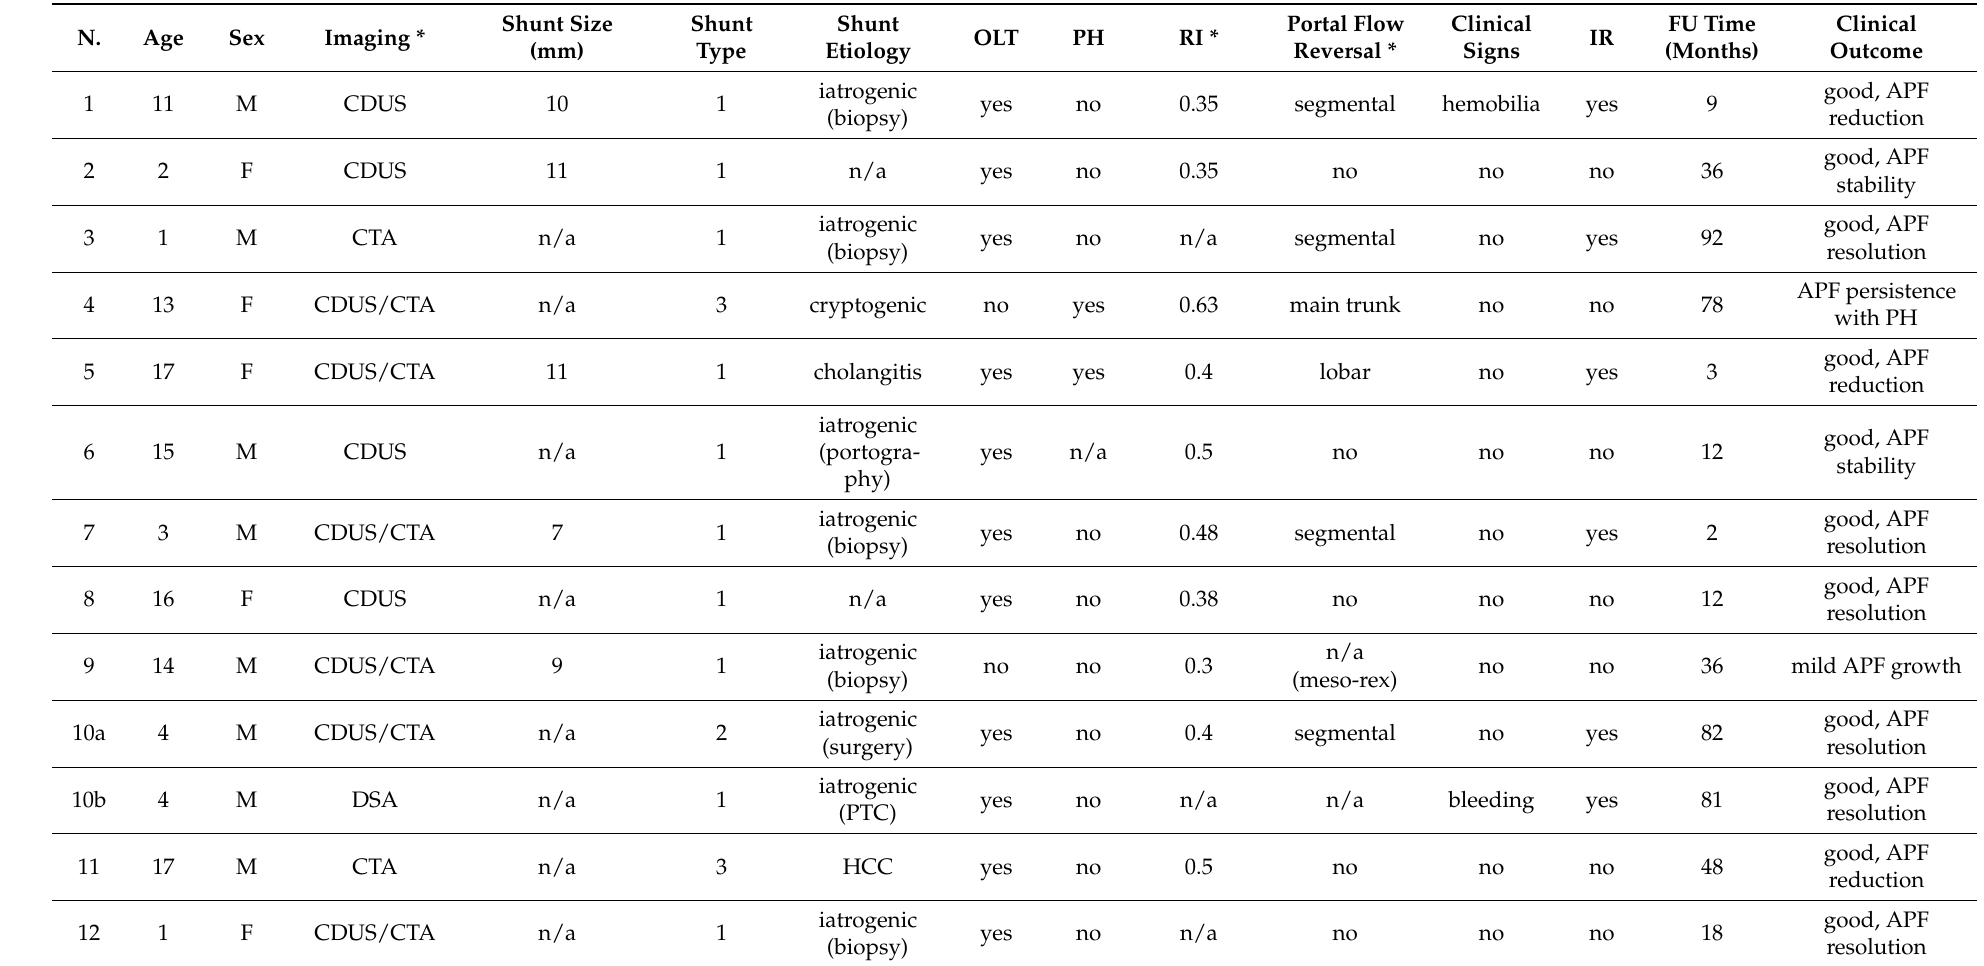
Table 1. Patients’ data, shunt features and general